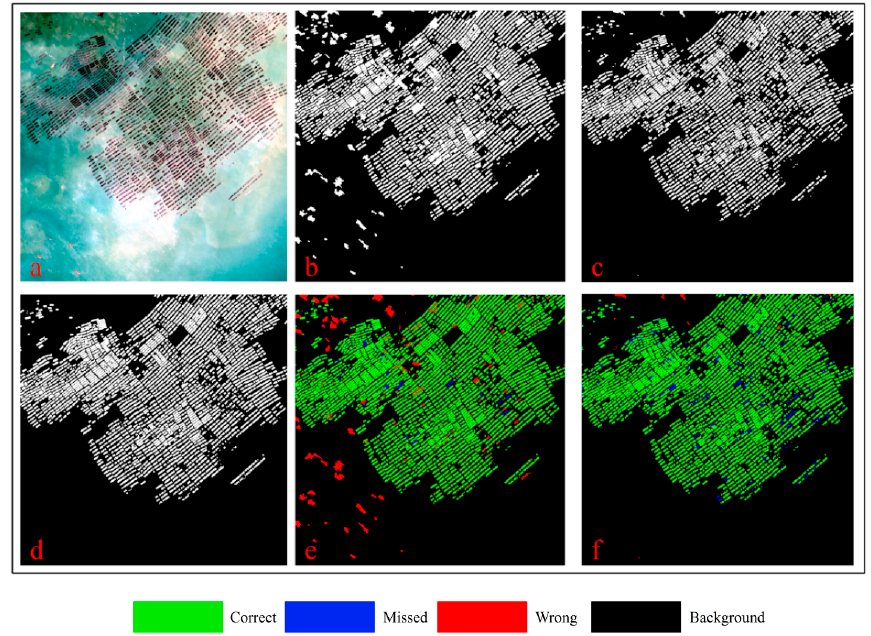
Figure 5. Results of two experimental methods for study area 1: ( a ) Initial image; ( b ) OBVS-NDVI extraction result; ( c ) Proposed extraction result; ( d ) Human interpretation result; ( e ) Overlap of OBVS-NDVI result with human interpretation result; ( f ) Overlap of proposed result with human interpretation result.